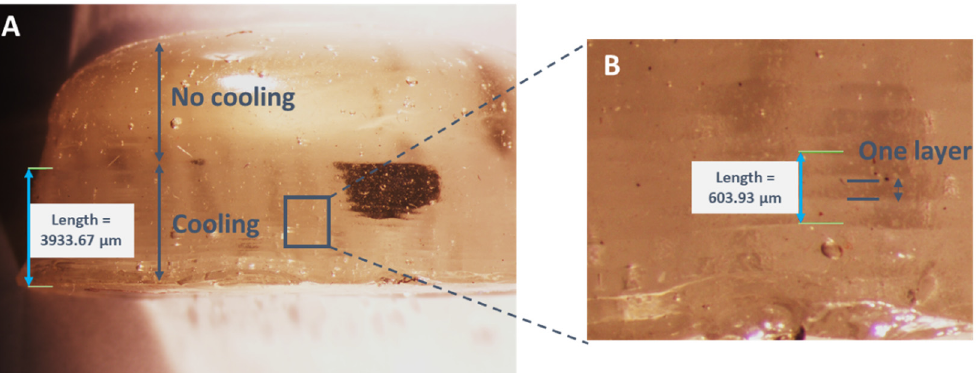
Figure 8. Effect of thermal gradient on the geometry of protein gels. ( A ) Examination of the printing defect due to lack of cooling. ( B ) Control of the thickness of the deposited layers.